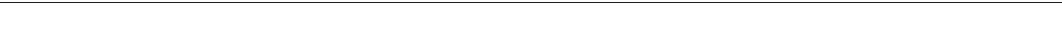
Fig. 5 In vitro therapeutic ef fi cacy and in vivo pharmacodynamics. a Western blotting showing the levels of each of the 6 kinases in the signature, in addition to their non-phosphorylated controls where applicable, in 10 human TNBC cell lines, the transplantable murine TNBC tumor model 4T1, and 2 patient-derived xenografts (PDXs). The three targets against which clinical-grade drugs are available are highlighted in red. b Colony assays (MDA-MB- 231) showing the differences between single-target versus two-target pharmacological blockade. For each of the 15 possible 2-by-2 drug combinations using the 6 agents against the kinases in K-high, a representative vehicle-treated well, representative single-agent-treated wells and a well containing the doublet are shown. All 4-well images belong to unique 12-well dishes. Representative images of three independent experiments. c In vivo dosage of imatinib, GDC-0994, and palbociclib at standard doses for animal use led to decreased AKT, P90RSK, and RB phosphorylation levels (targets of the kinases c-Kit, ERK, and CDK6, respectively) in MDA-MB-231-xenografted tumors after 24 h. The right panel shows total PNKP levels in wild-type (upper) and CRISPR PNKP MDA-MB-231 transfectant (lower panels) tumors. Scale bar, 50 μ